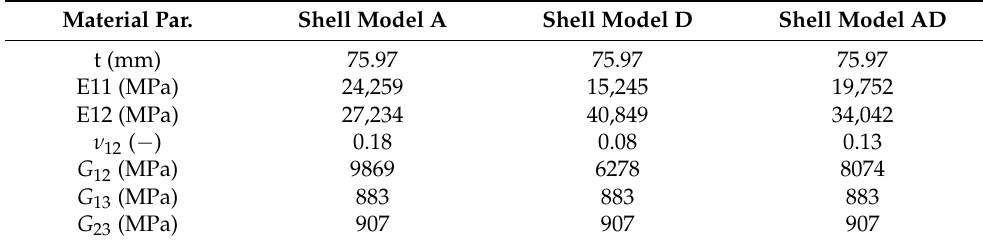
Table 3. Material properties computed after homogenization of the RVE-1 model. Three different sets of parameters using Equations (13), (14) or (15).